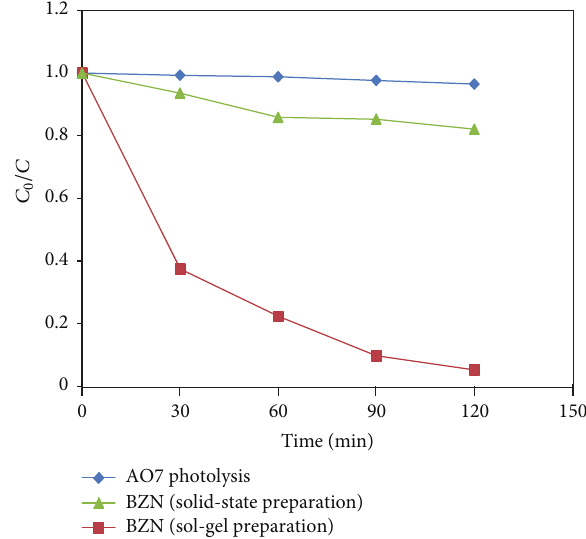
Figure 5: The changes in concentration of the AO7 dye solution under UV irradiation with and without the BZN